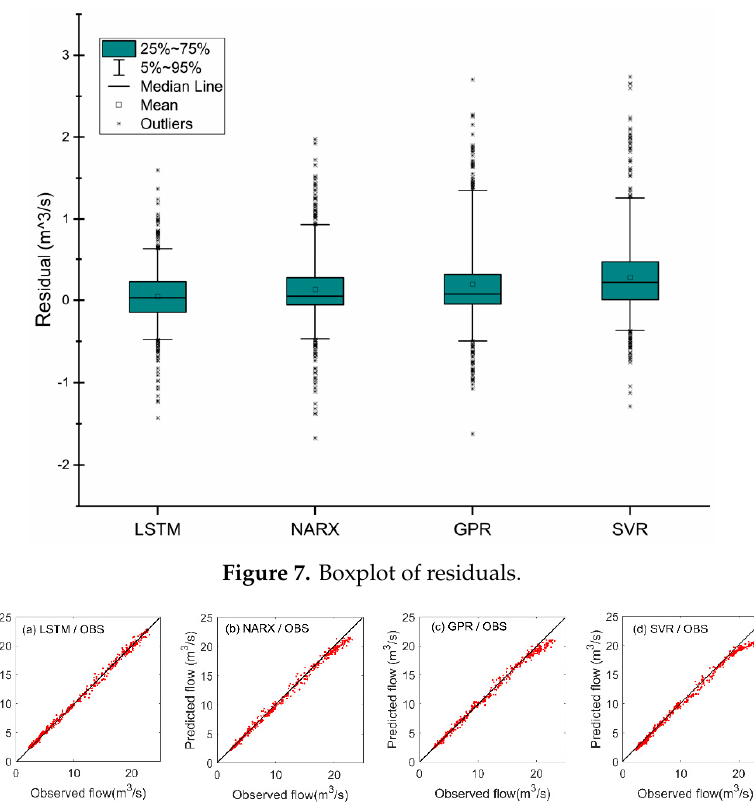
Figure 8. Scatter plot of predicted flow with observed flow ( a ) LSTM model ( b ) NARX model ( c ) GPR model ( d ) SVR model. The solid line is the 1:1 line.